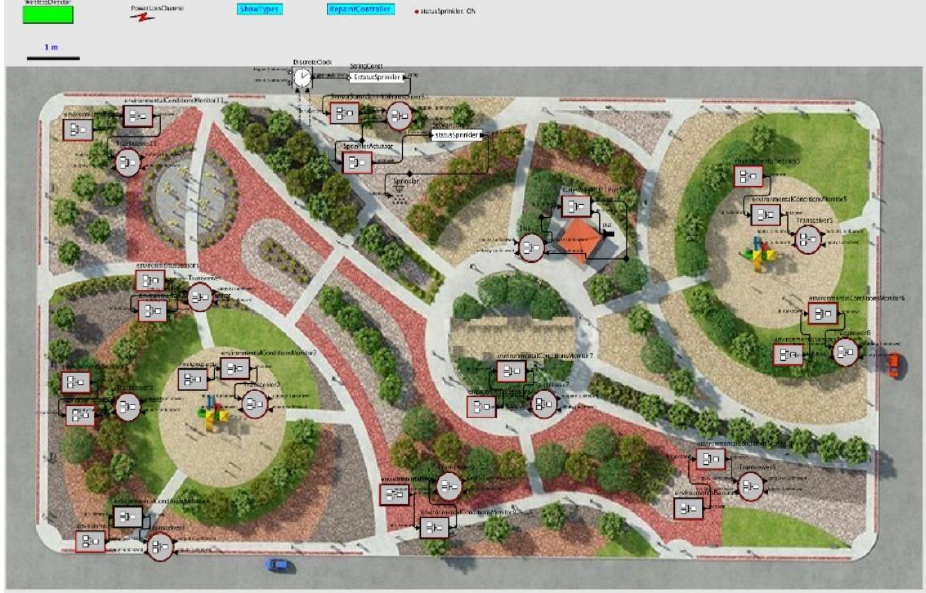
Appl. Sci. 2021 , 11 , x FOR PEER REVIEW Figure 2. Location of the sensors, the actuator, and the gateway in a park. Figure 2. Location of the sensors, the actuator, and the gateway in a park.